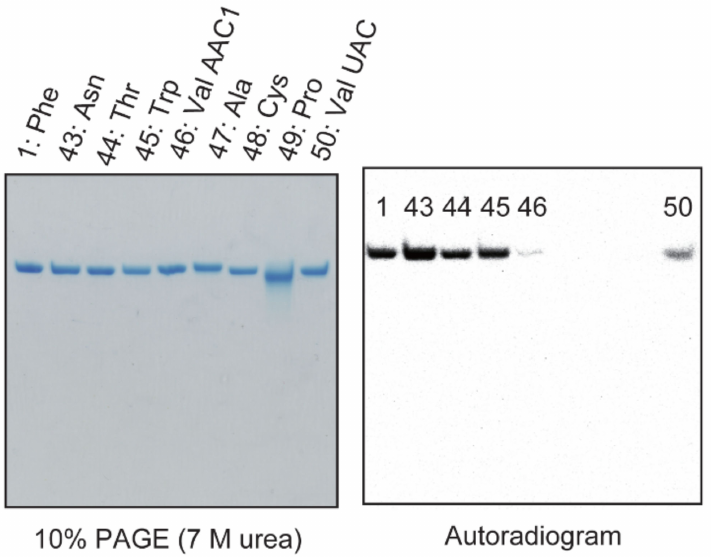
Figure 8. Methylation of nine tRNA transcripts by Trm11-Trm112. Nine tRNA (tRNA Phe , tRNA Asn , tRNA Thr , tRNA Trp , tRNA Val AAC1 , tRNA Ala , tRNA Cys , tRNA Pro and tRNA Val UAC ) transcripts were incubated with Trm11-Trm112 and 14 C-AdoMet, and 0.025 A260 units of each tRNA were loaded onto a 10% polyacrylamide gel containing 7 M urea. After electrophoresis, an autoradiogram of the gel was obtained. Because the methyl-transfer reaction was stopped after a 2 min, the data in the autoradiogram show the relative initial